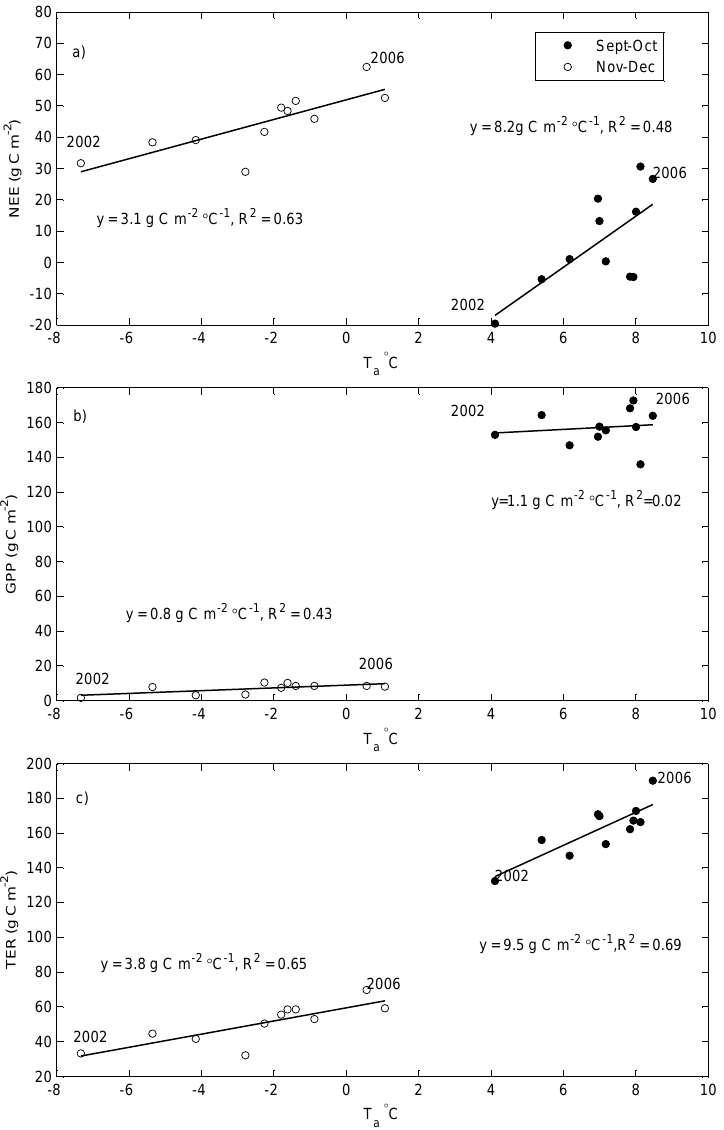
Fig. 4. Cumulative NEE (a) , GPP (b) and TER (c) over the early (September–October) and late autumn (November–December) as a function of the average air temperature ( T a ) for the corresponding bimonthly periods. The linear least-squares regressions give the temperature